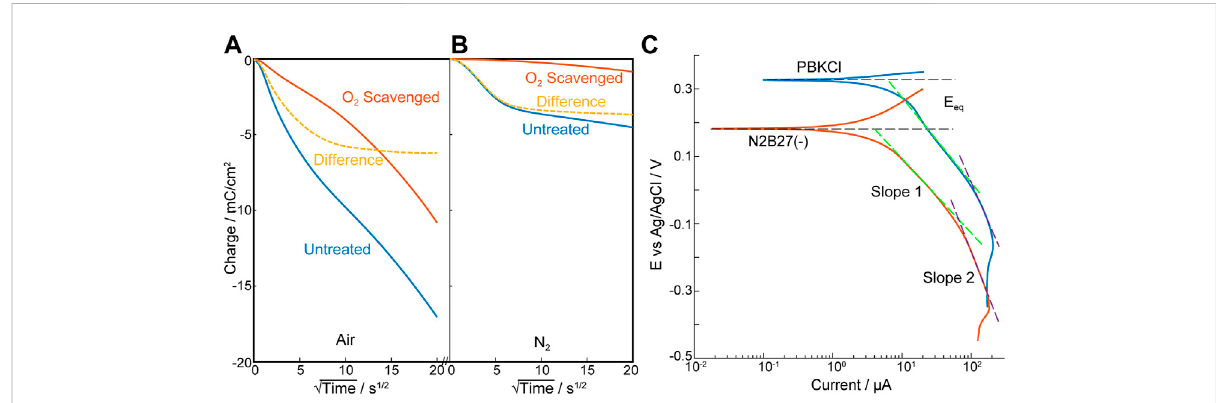
FIGURE 2 Characterization of the scavenging electrode — Pt/C. (A,B) Anson plots of oxygen adsorption and scavenging analysis of Pt/C electrode, polarizedat-0.7 Vvs.Ag/AgClelectrodeinPBKClmeasuredinair (A) andnitrogen (B) .O 2 scavengedPt/Celectrode (Red);UntreatedPt/Celectrode (Blue); Difference (Yellow dotted). (C) . Tafel plot of Pt/C electrode under 20.9% O 2 in PBKCl and N2B27( – ) respectively ( n = 3).